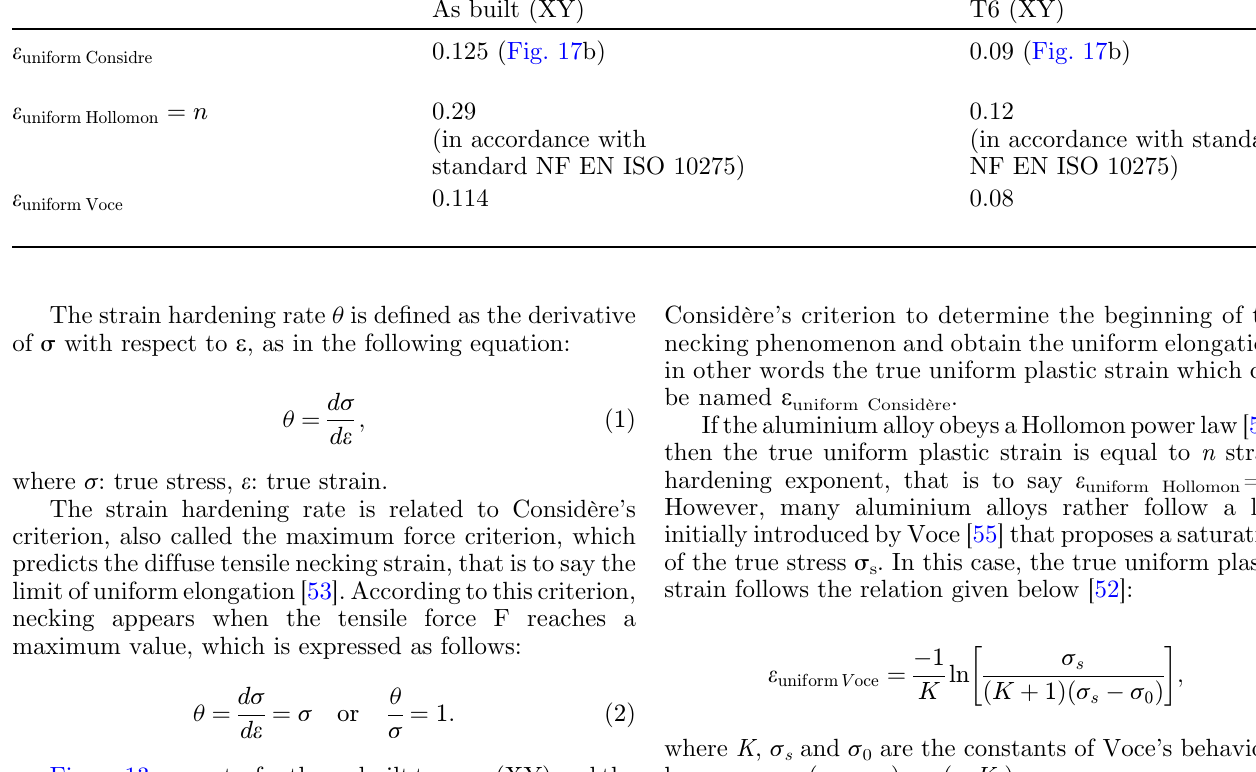
Table 5. True uniform plastic strains (cid:1) as-built and T6 tempers. As built